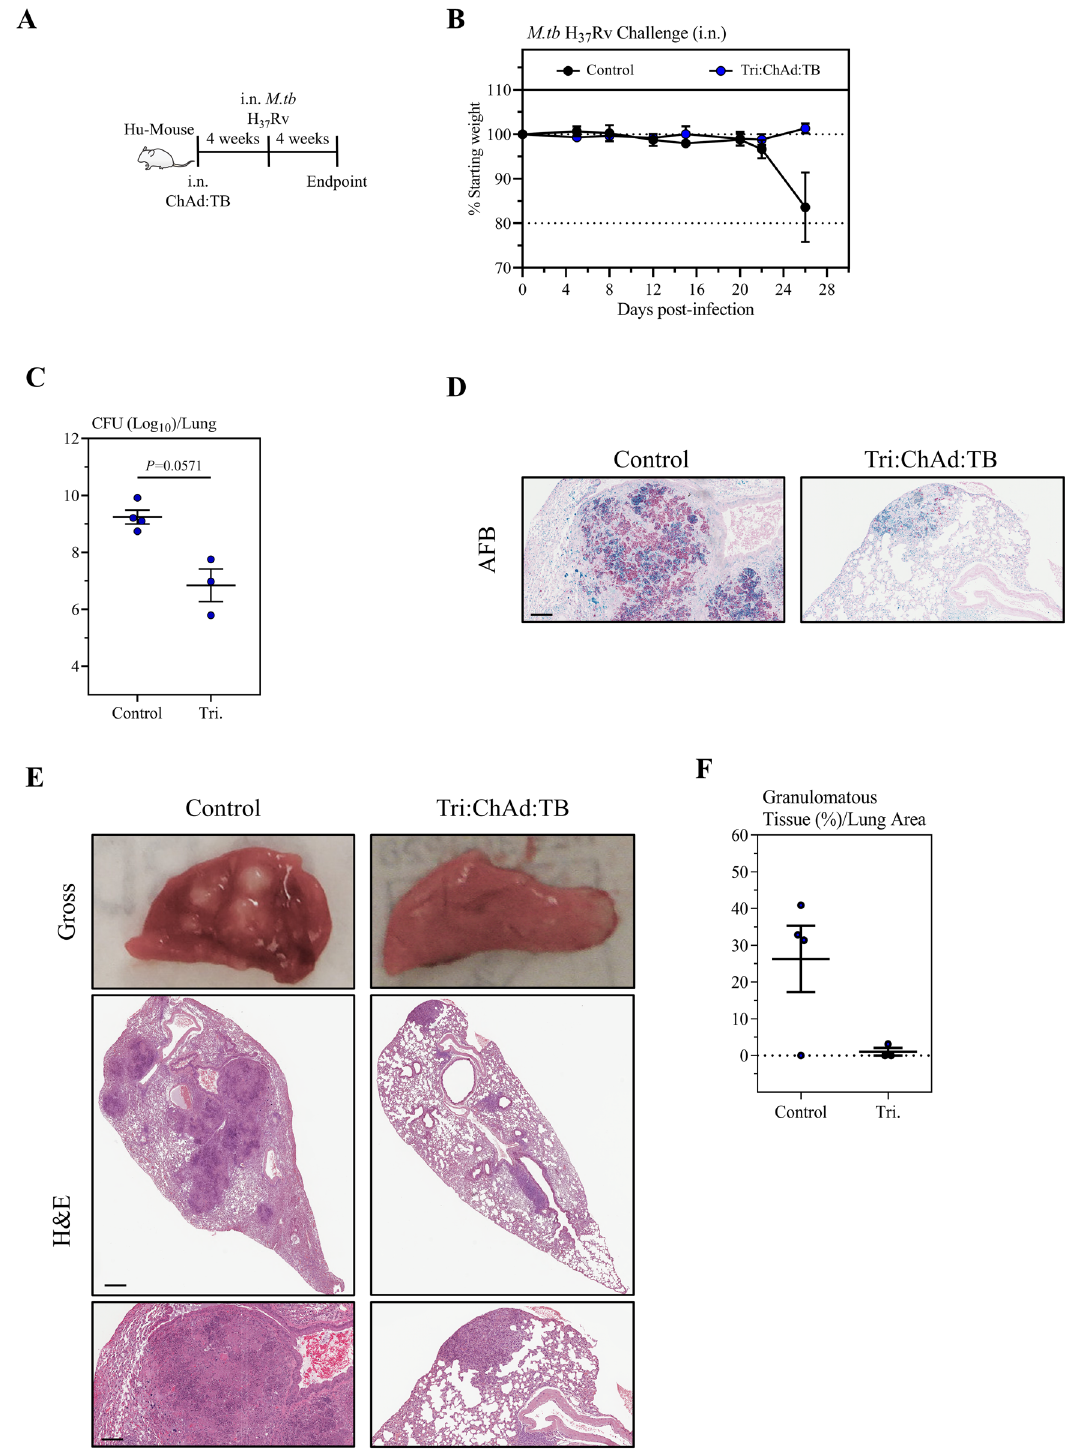
Fig. 6 Protective ef fi cacy of a multivalent ChAd:TB vaccine against M.tb (H 37 Rv) in the humanized mouse (Hu-mouse) model. A Experimental schema. B Body weight change curve following respiratory mucosal challenge with M.tb (H 37 Rv). C Lung mycobacterial burden (Log 10 colony-forming unit (CFU)) 4 weeks post- M.tb challenge. D Representative lung histopathological images of acid-fast Bacilli (AFB) staining 4 weeks post- M.tb challenge. Scale bars represent 100 µm. E Top: Representative gross lung pathological images Scale bars represent 200 µm. Bottom: Representative lung histopathological images of H&E staining. Scale bars represent 100 µm. F Scatter plots depicting percentage areas of granulomatous lesions in the lungs. Data presented in ( B , C , F ) represent mean ± SEM of n = 3 – 4 mice/group. Data are representative of one independent experiment. Statistical analysis for ( C ) was performed using a nonparametric Mann – Whitney T tests.